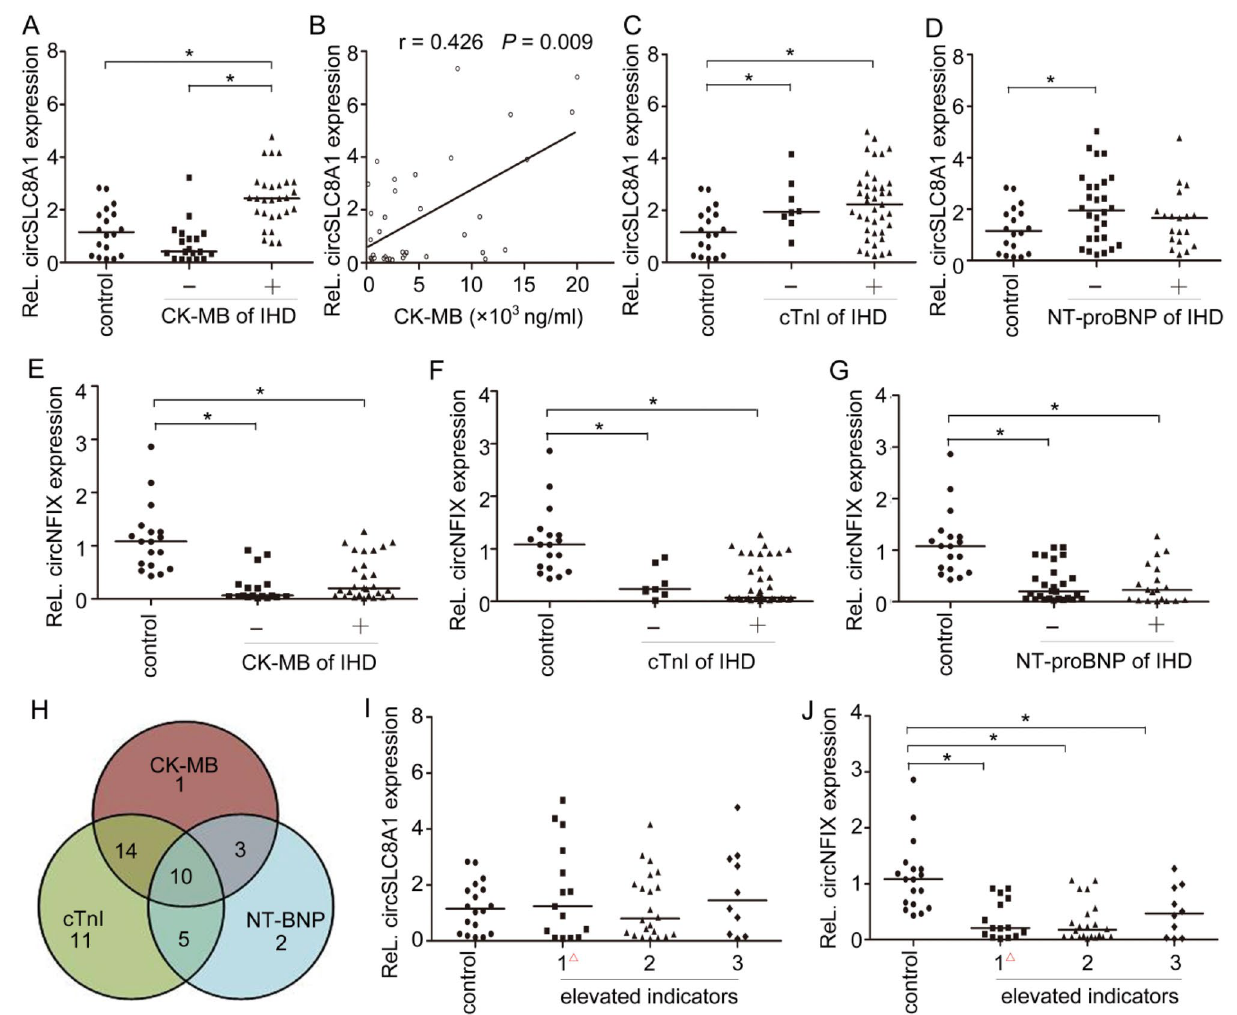
Figure 7. Relationships between the two circRNAs and traditional biomarkers in the pericardial fluid. CK-MB, creatine kinase MB; cTnI, cardiac troponin I; NT-proBNP, N-terminal pro-B-type natriuretic peptide. (A) CircSLC8A1 expression in cardiac tissues from decedents with different levels of CK-MB. Differences between groups were analyzed using Mann–Whitney U-test. * P < 0.05. (B) Scatter plot for the IHD group with CK-MB concentration on the X axis and circSLC8A1 expression on the Y axis. (C) CircSLC8A1 expression in cardiac tissues from decedents with different levels of cTnI and NT-proBNP in the pericardial fluid, Differences between groups were analyzed using Mann–Whitney U-test. * P < 0.05. (E–G) CircNFIX expression in cardiac tissues from decedents with different levels of CK-MB, cTnI and NT-proBNP in the pericardial fluid. Differences between groups were analyzed using Mann–Whitney U-test. * P < 0.05. (H) Venn diagram of biomarkers and their relationships. (I, J) Expression of circSLC8A1 and circNFIX in cardiac tissues from decedents with elevated levels of the indicated number of biomarkers (CK-MB, cTnI and NT-proBNP) in the pericardial fluid. △ 0